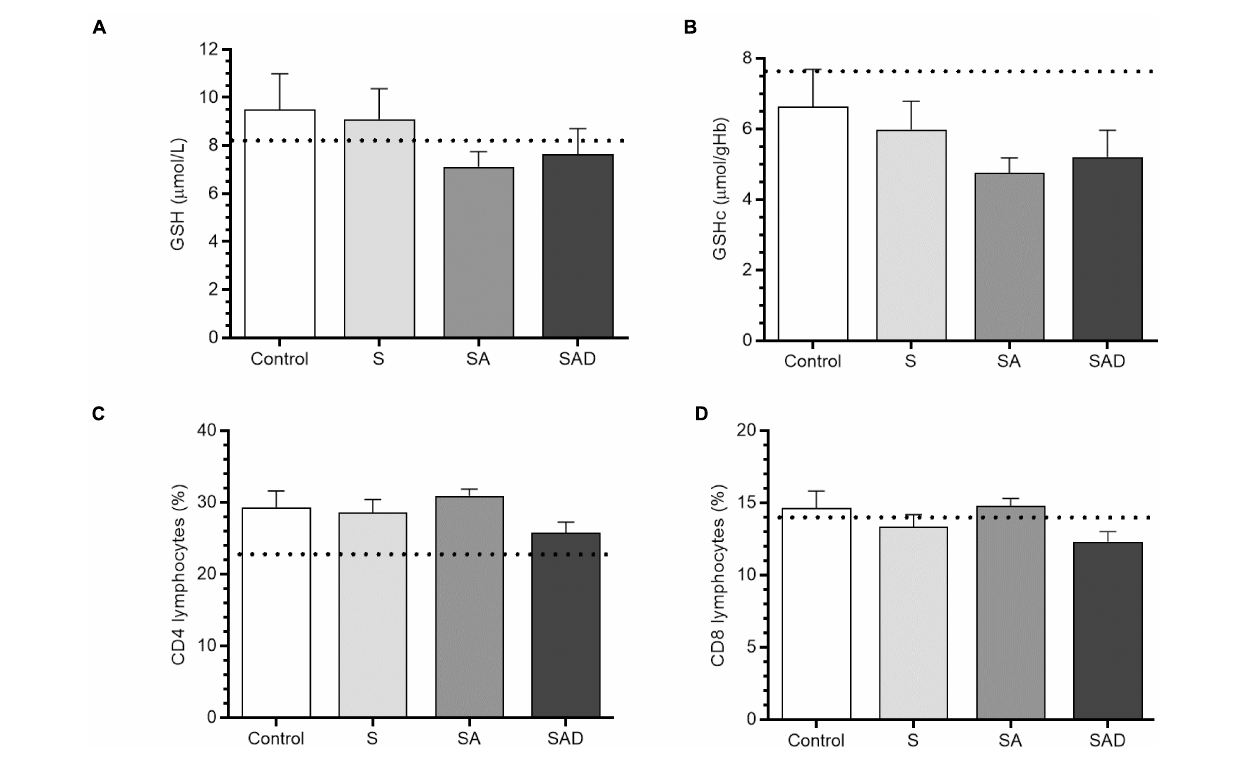
FIGURE 3 | Antioxidant (A,B) and immune (C,D) parameters. The following groups were compared: S, stress; SA, stress and anxiety symptoms; SAD, stress, anxiety, and depression symptoms. The dashed line shows the average value for healthy subjects (A,B) and the lower limit of the reference range (C,D) . The results are expressed as mean ±